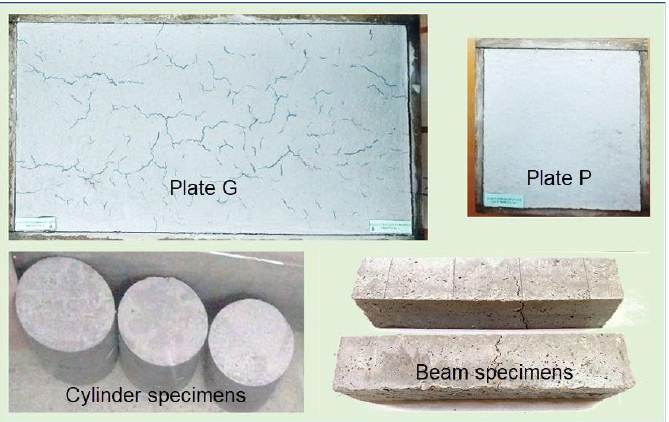
Figure 5. Type of test specimens used in the project.